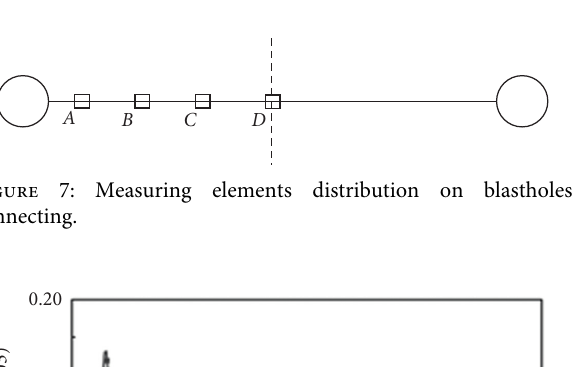
Figure 6: Process of cracks propagation. (a) t � 20 μ s, (b) t � 80 μ s, (c) t � 100 μ s, (d) t � 160 μ s, (e) t � 260 μ s.